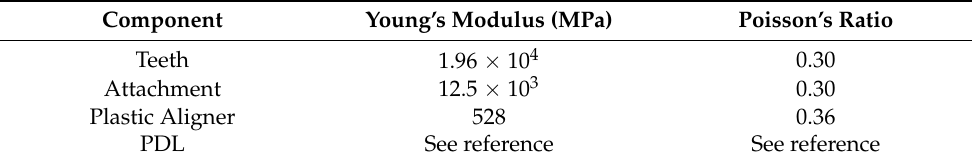
Table 1. Materials’